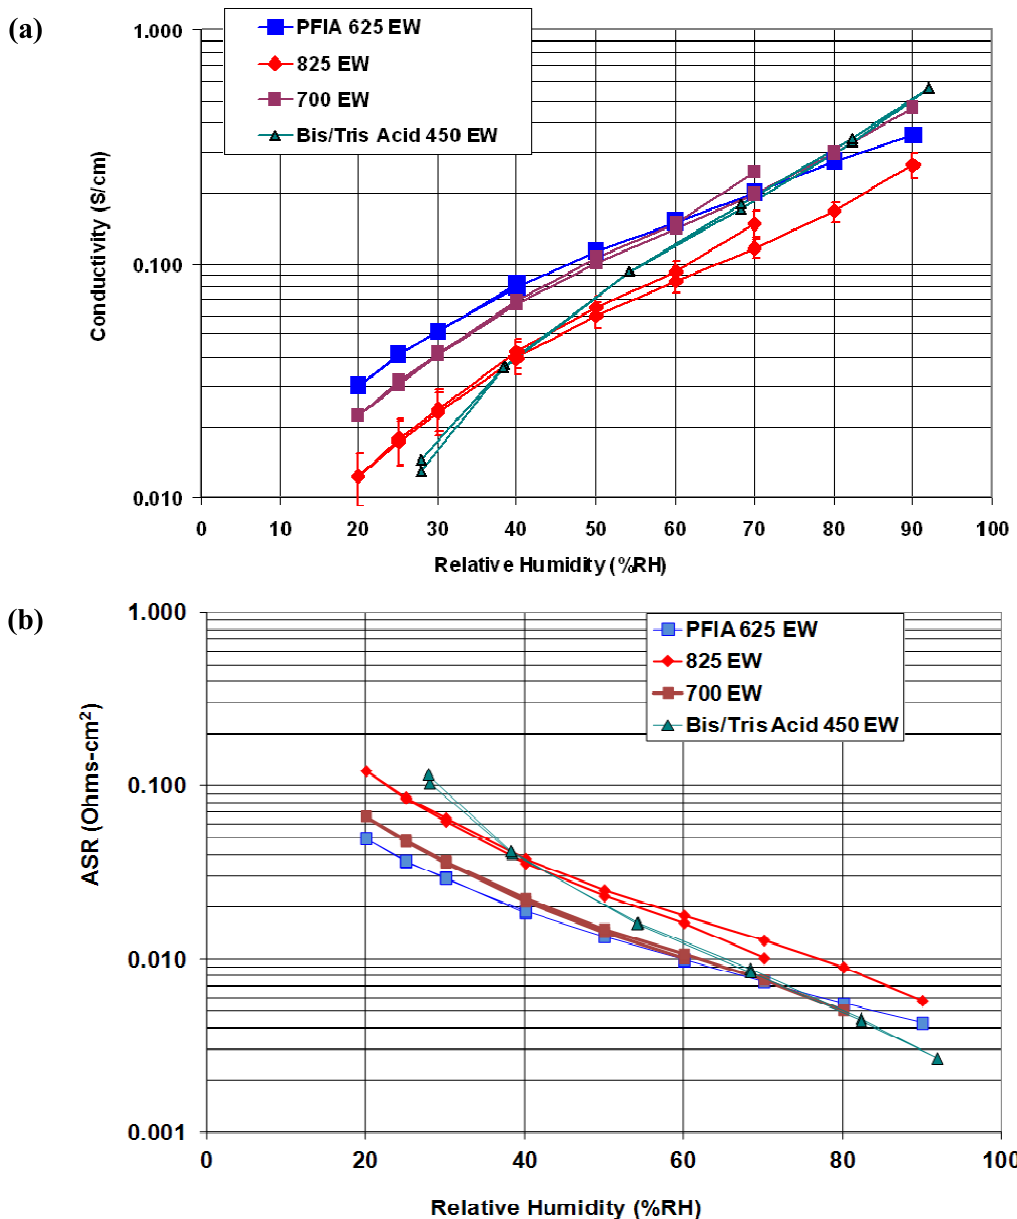
Figure 2. Conductivity of several 3M membranes at 80 °C over a range of relative humidity (RH) showing that low EW perfluoroimide acid (PFIA) has similar conductivity as 700 EW PFSA [31]. ( a ) The experimentally measured conductivity; ( b ) the calculated ASR for 15 micron